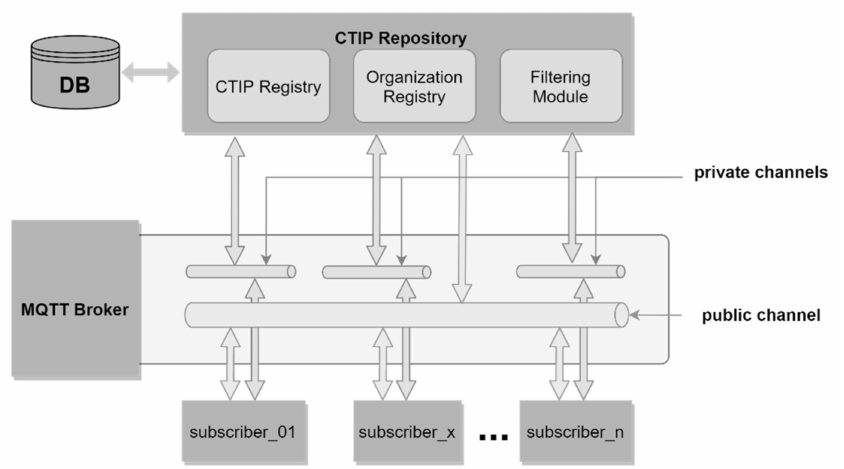
Figure 9. Architecture of the proposed CTIP sharing